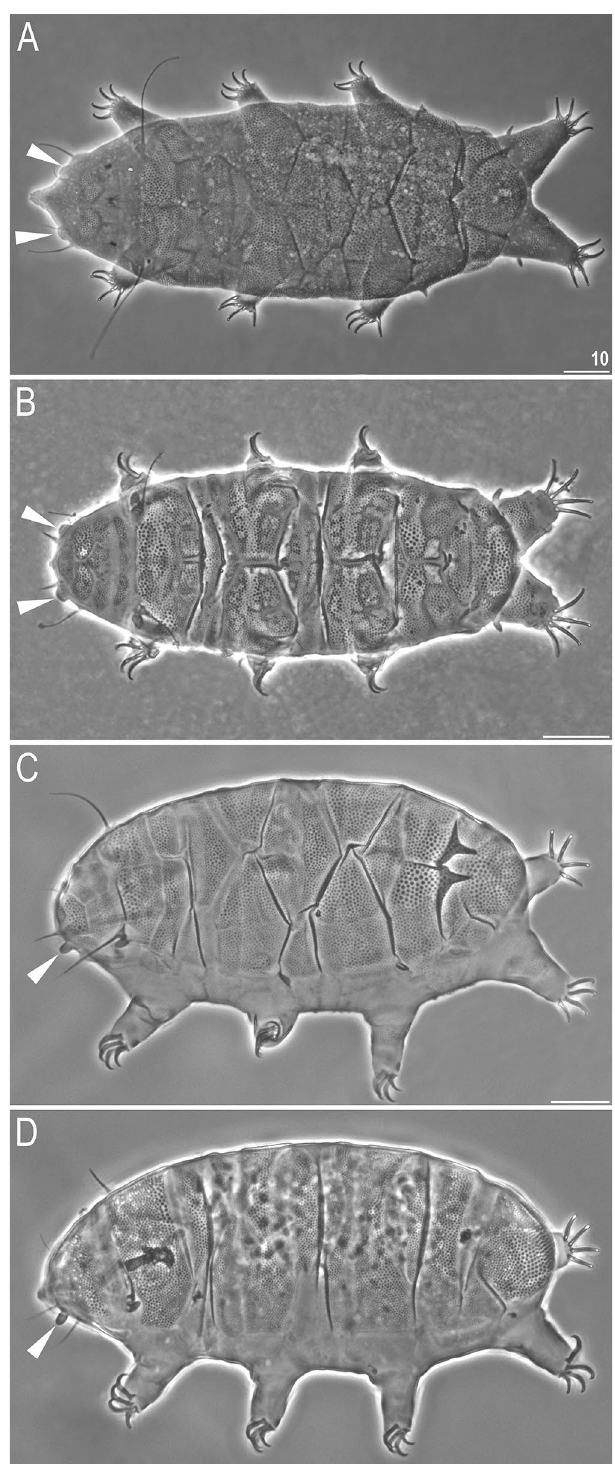
Figure 1. Exemplary representatives of the former suillus-facettalis lineage: ( A ) Pseudechiniscus (P.) insolitus (paratype, Spain), ( B ) Pseudechiniscus (P.) jubatus (paratype, Russia), and the novaezeelandiae lineage: ( C ) Pseudechiniscus (M.) novaezeelandiae (Te Ika-a-Māui), (D) Pseudechiniscus (M.) juanitae (Colombia). Arrowheads indicate cephalic papillae. Scale bars = 10